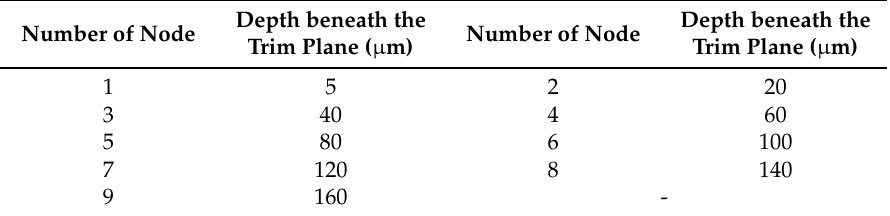
Figure 10. Scheme of selected interface nodes in the CFRP/Ti model. Table 8. Y ‐ displacement from the trim plane of selected nodes in the interface zone.